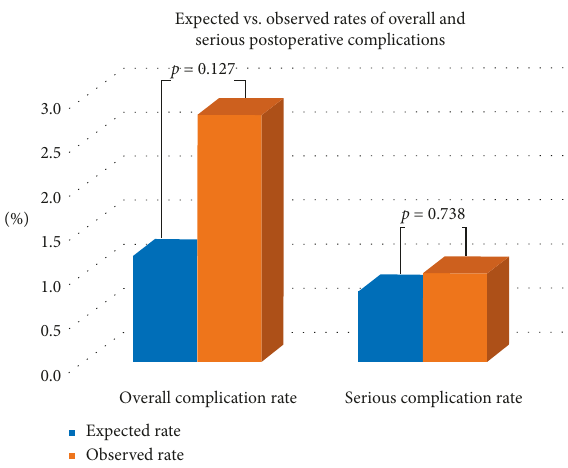
Figure 1: Expected vs. observed postoperative overall and serious complication